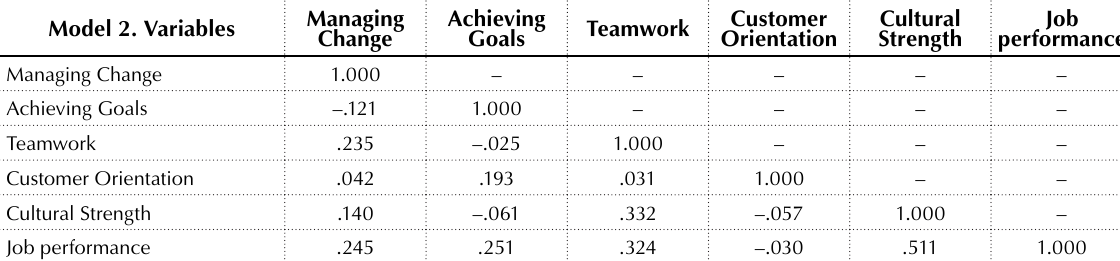
Table 9. Inter-item correlation matrix Model 2.